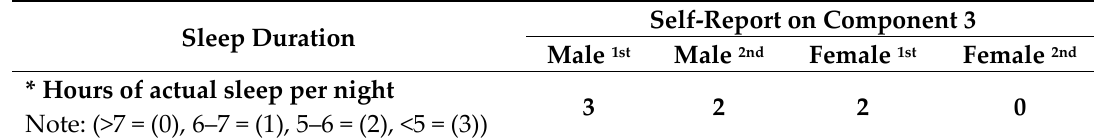
Table 3. Component 3 of the PSQI on the 4 flight attendants.